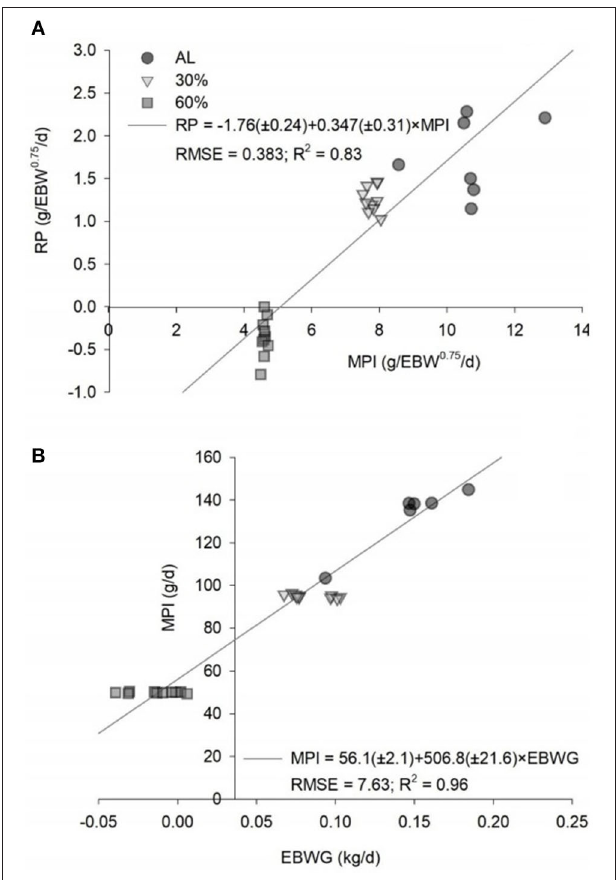
FIGURE 2 | Predicted equations by the relationships (A) between the retained protein (RP) and the metabolizable protein intake (MPI) and (B) between the MPI and the empty BW gain (EBWG) of ad libitum (AL), 30% of feed restriction (30%) and 60% of feed restriction (60%) of intact male Dorper × Santa Ines lambs. EBW, empty body weight; RMSE, root mean square